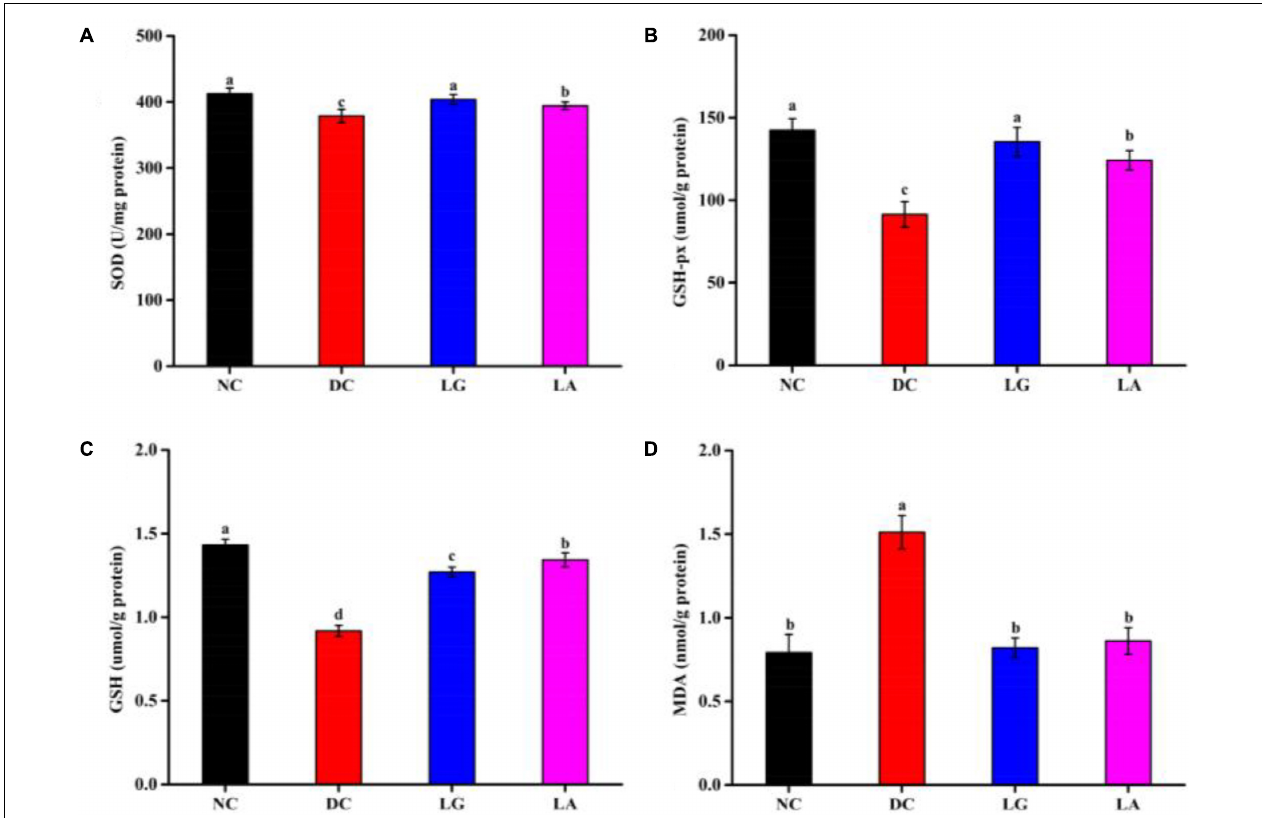
FIGURE 6 | Effect of probiotic feeding on oxidative stress in blood. (A) Superoxide dismutase (SOD). (B) Glutathione peroxidase (GSH-Px). (C) Glutathione (GSH). (D) Malondialdehyde (MDA). NC, normal control group; DC, diabetic control group; LG, DC plus L. rhamnosus GG; LA, DC plus L. acidophilus KLDS1.0901. Values are expressed as mean ± SD ( n = 8 independent experiments). Values with different superscript letters are significantly different ( p < 0.05).